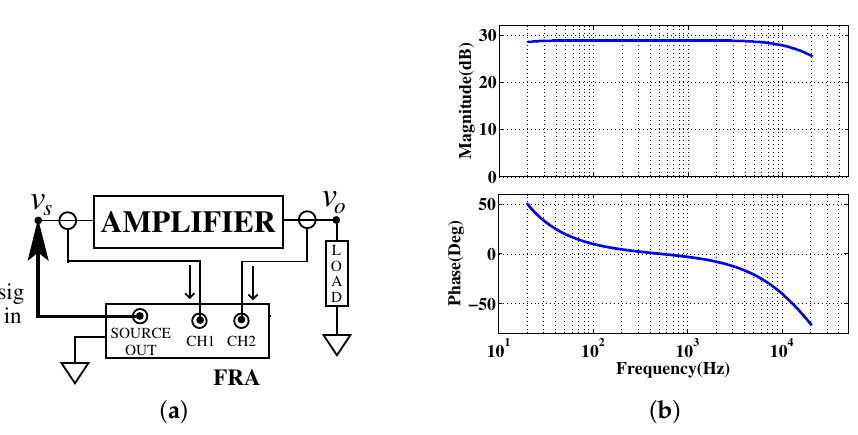
Figure 16. ( a ) Schematic for frequency response acquisition, ( b ) frequency response plot. To further evaluate linearity of the amplifier, the total harmonic distortion (THD) of the output signal v o , at 1 W power level, in the 1–10 kHz range was calculated and plotted. Since the amplifier’s input signal, v s , itself contains harmonic components, an algorithm to accurately calculate the THD of the output signal, v o , is developed, which is illustrated in Figure 17. Notations used in the algorithm are explained in Table 6.